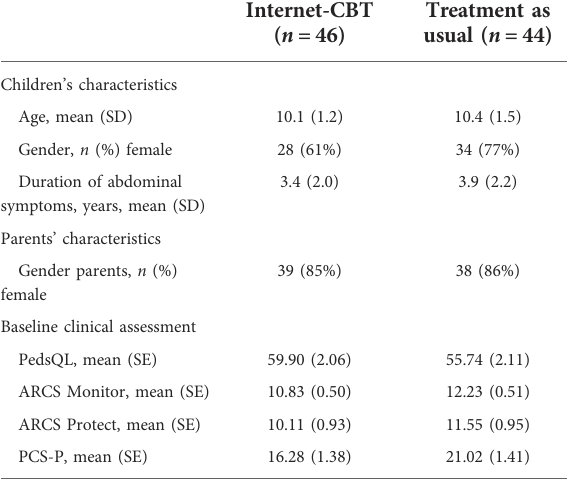
TABLE 2 Demographic and clinical characteristics ( n =90).